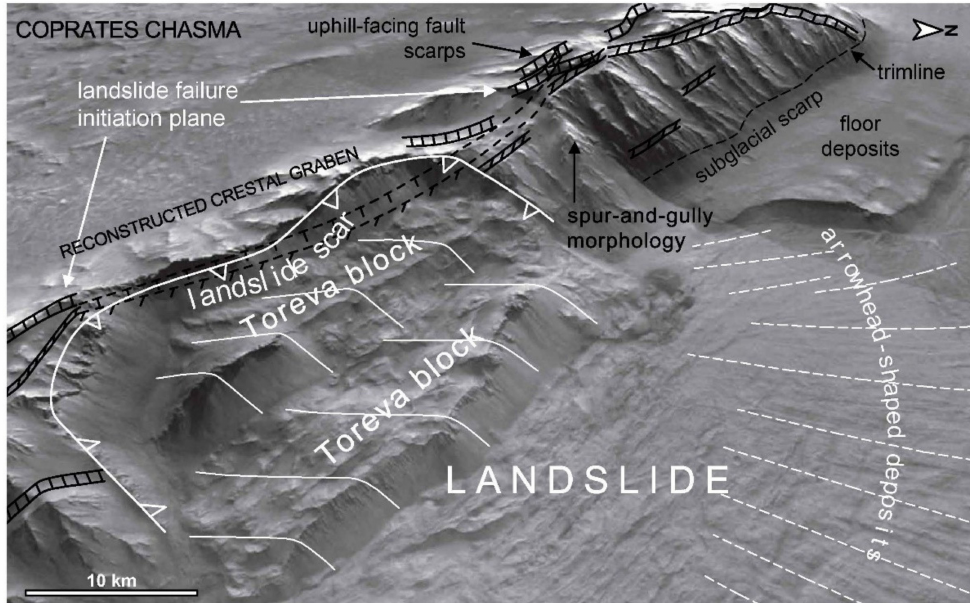
Figure 10. Example of large landslides related to DSGSD on the northern slope of Coprates Montes, in the central sector of Coprates Chasma; redrawn after M è ge and Bourgeois [60]. The landslide scar is aligned with the uphill-facing scarps of large-scale gravitational deformation involving the internal ridge, highlighting the relation between slope failure and DSGSD. The Mars image was produced with a THEMIS image mosaic draped over a HRSC digital elevation